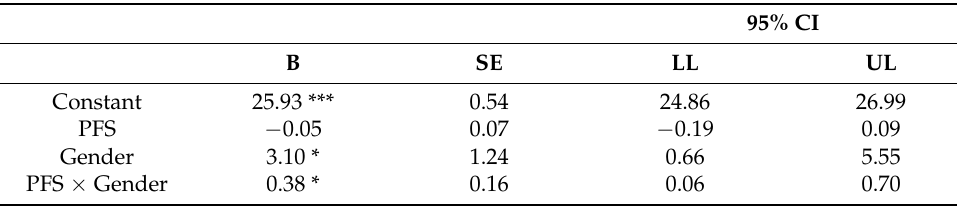
Table 11. Unstandardized regression coefficients for Model